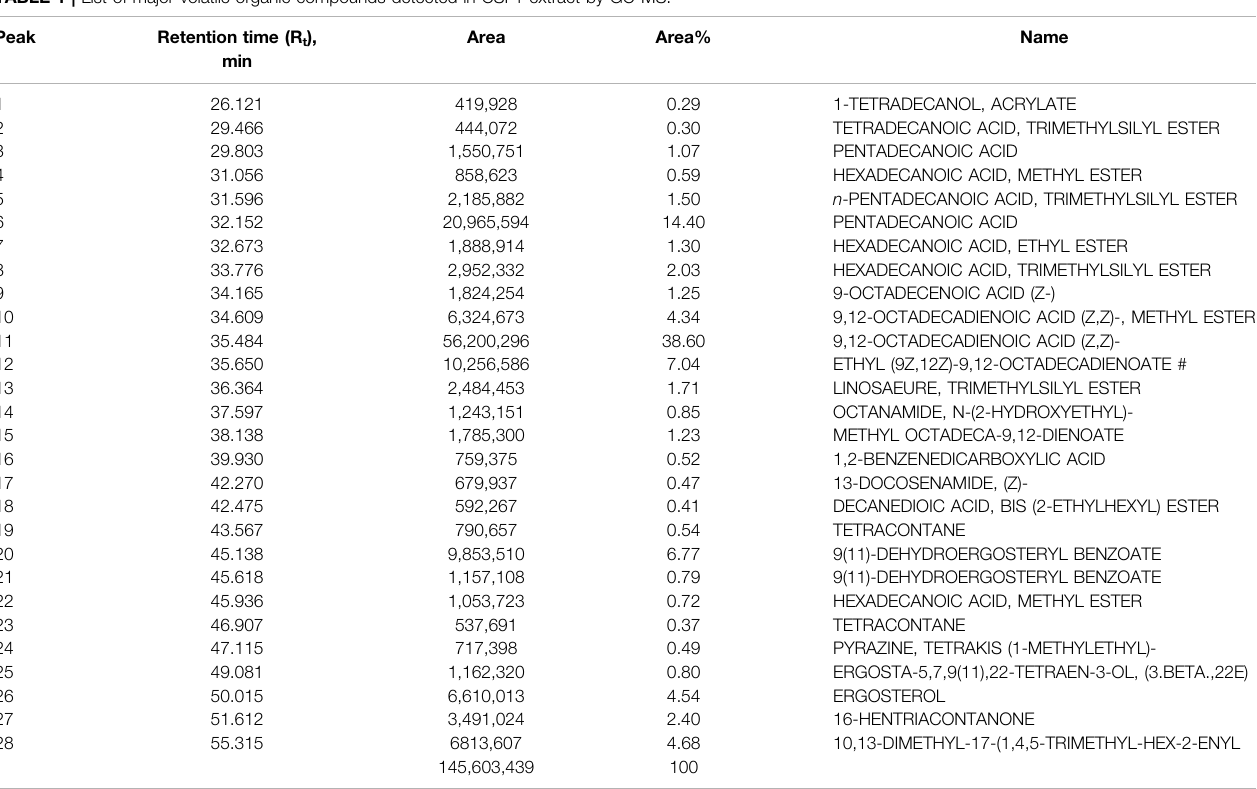
The retention times, peak areas and area percentages are